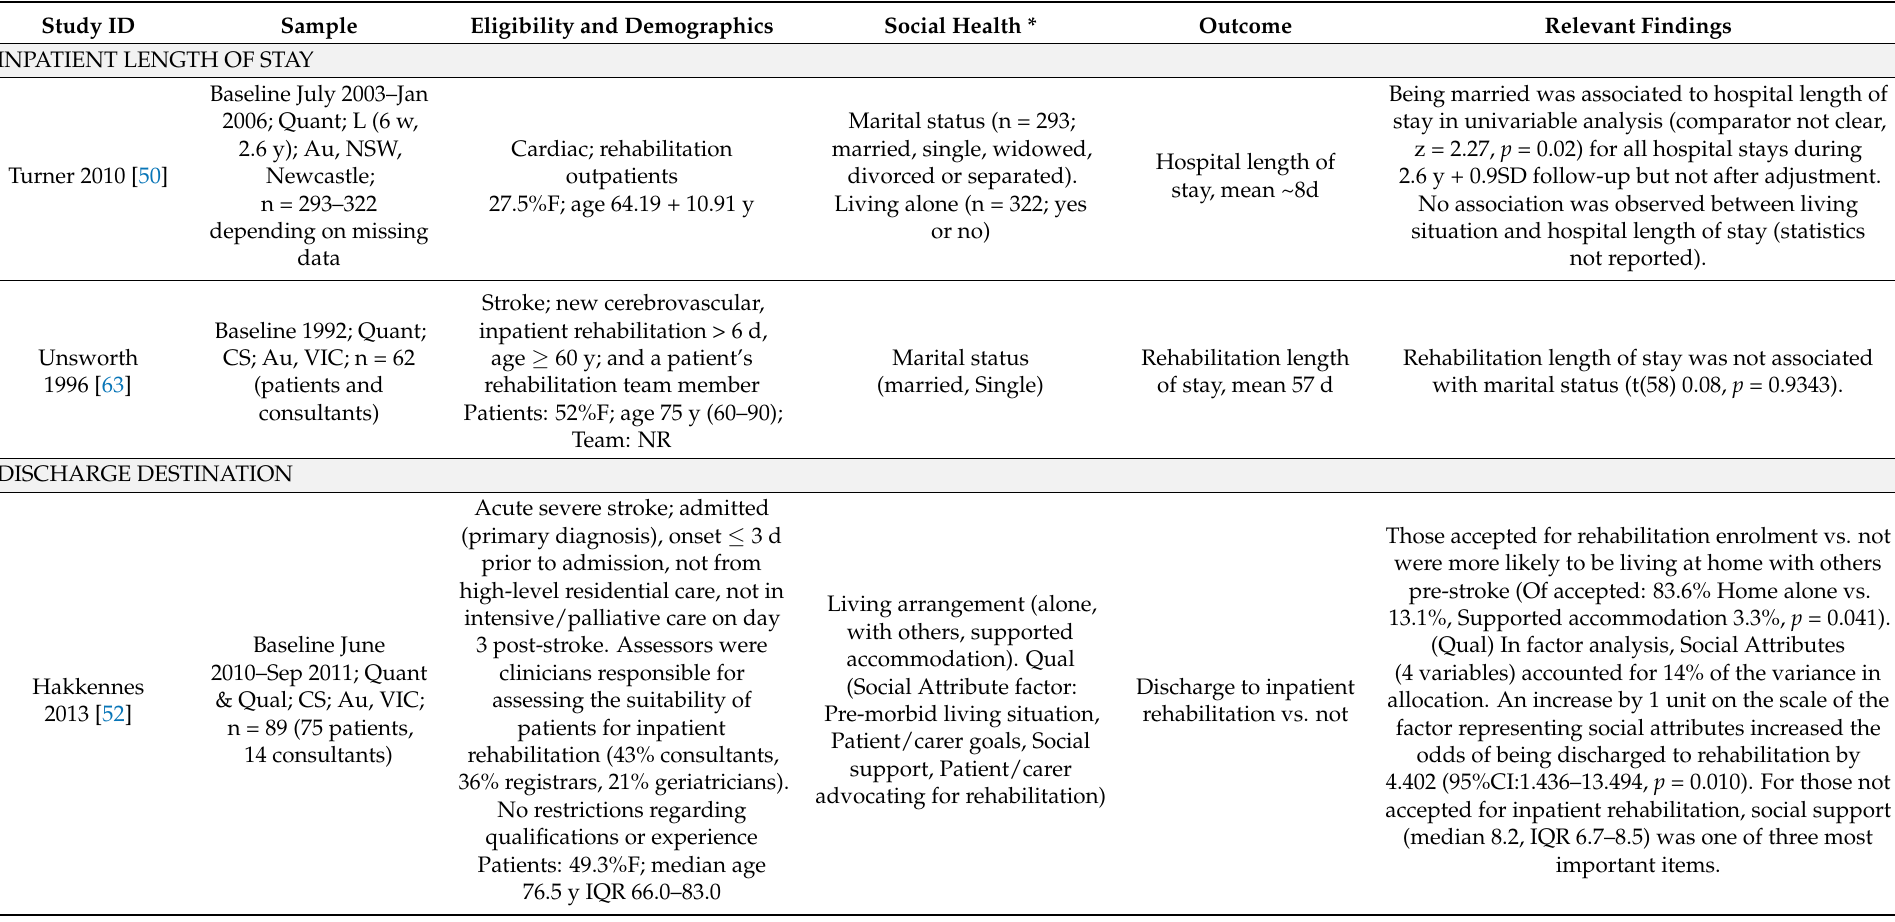
Table 1. Characteristics and relevant findings of included